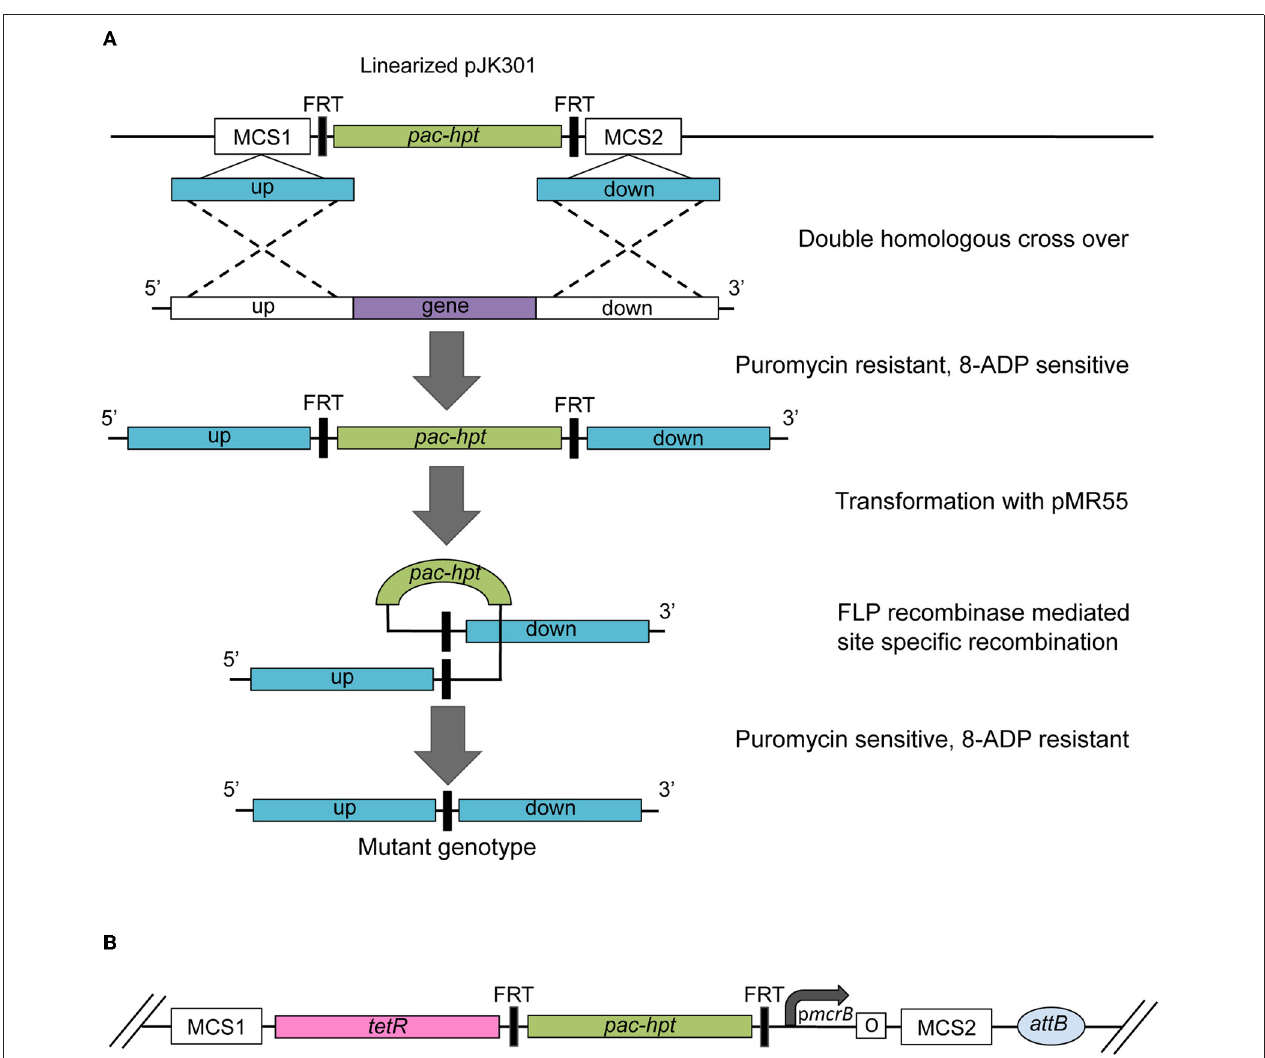
FIGURE 3 | (A) Schematic of the construction of an unmarked deletion mutant strain using pMPJK301 and pMR55. The pac - hpt cassette of plasmid pMJK301 is flanked by the homologousup- and downstream regions of the target gene. The linearized plasmid is transformed into a Methanosarcina (cid:2) hpt strain. A double homologousrecombination event (dotted line) creates a puromycin resistant and 8-aza-2,6-diaminopurine(8-ADP) marked deletion mutant.Successivetransformationwith plasmid pMR55resultsin theremoval